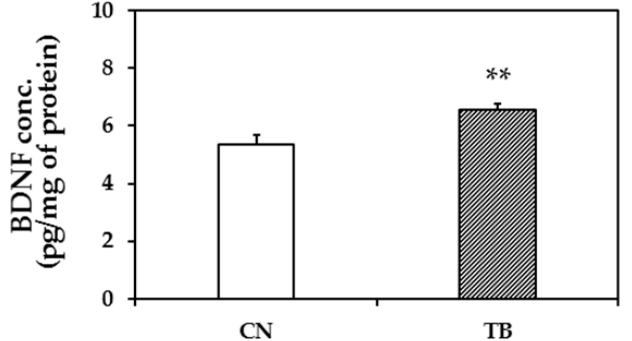
Figure 4. The effect of theobromine (TB) on the brain-derived neurotrophic factor (BDNF) protein level in the medial prefrontal cortex (mPFC). BDNF protein level in the mPFC of TB-fed rats (TB rats) was significantly higher than that of control rats (CN rats). Hippocampal BDNF protein levels did not differ between groups (Figure S1). Values are the mean ± S.E.M. ( n = 5 for each group). ** p < 0.01; significant difference between groups.